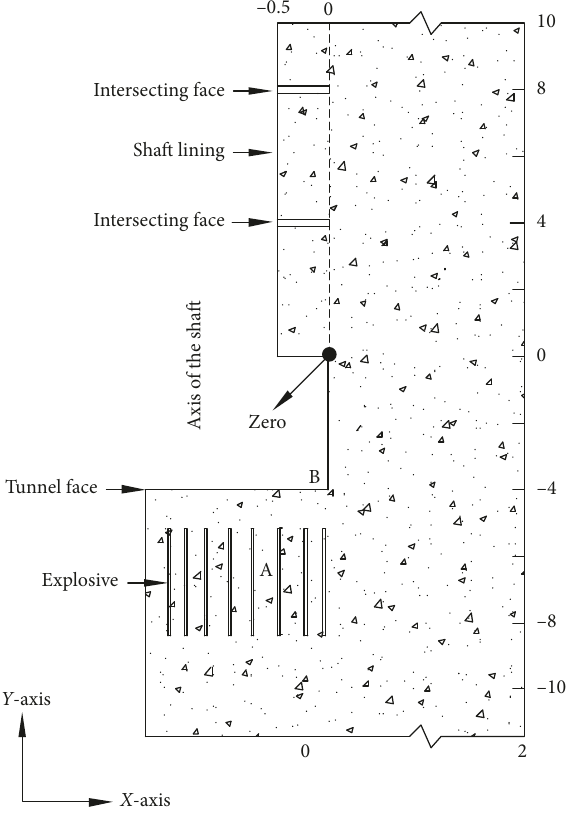
Figure 1: General model of the shaft wall (cm). Note: the directions and proportions of the X and Y axes are different. The scale along the X axis is not the same as that along the Y